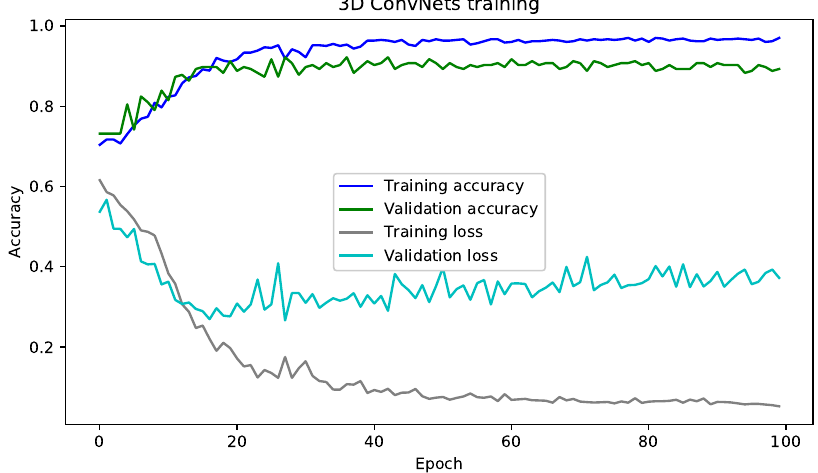
Figure 9. Result training for 3D ConvNets.